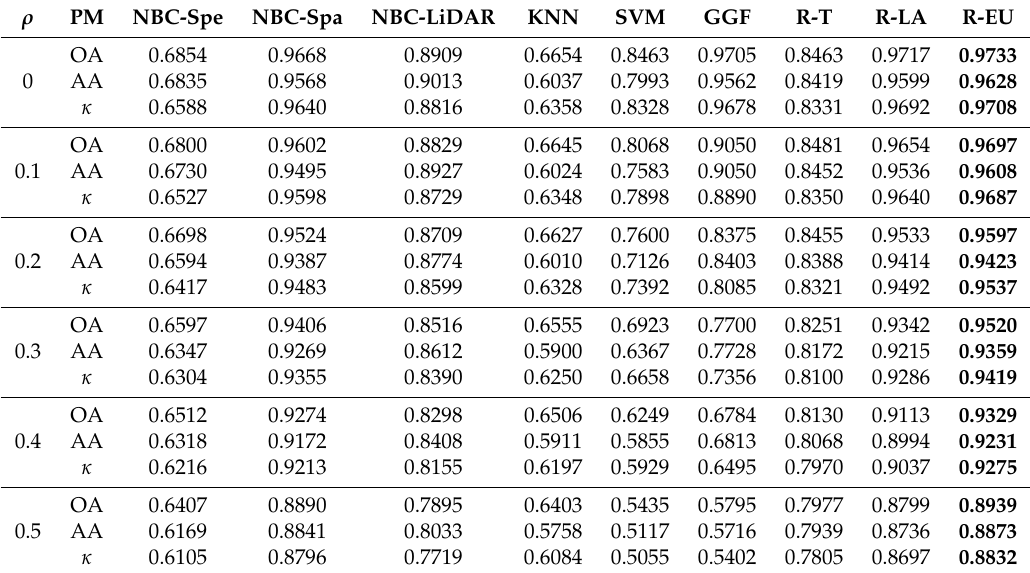
Table 10. Classification results for the GRSS2013 data set with different